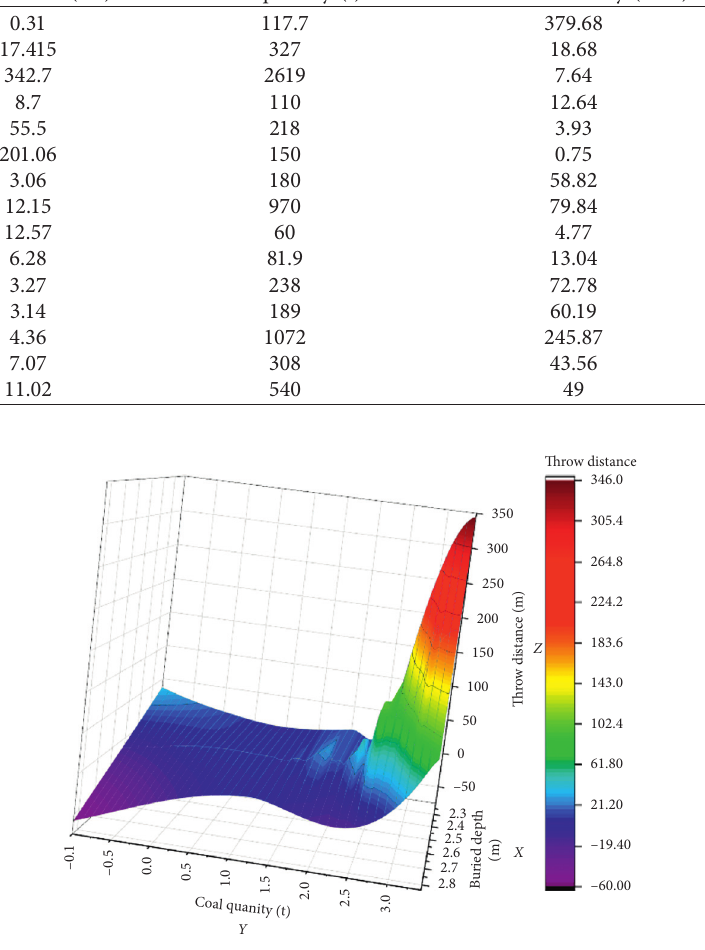
Figure 9: 3D colormap surface of buried depth, coal quantity, and throw distance ( XYZ log